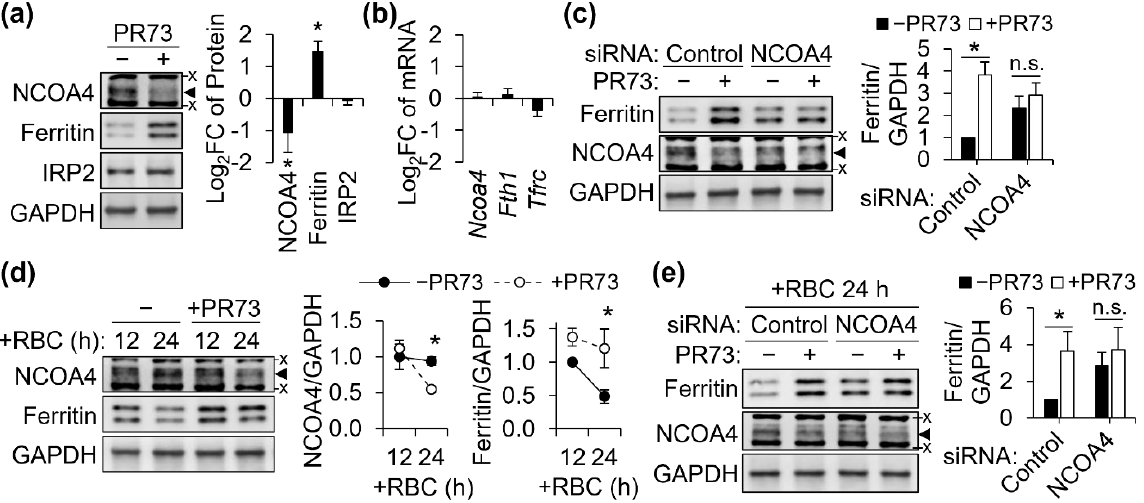
Figure 5. Hepcidin activity post-transcriptionally represses NCOA4 in J774 macrophages. J774 cells were treated with PR73, a minihepcidin analog, to mimic the biological effects of hepcidin in vitro. In experiments involving erythrophagocytosis, J774 cells were treated with opsonized red cells 4 h before PR73 treatment. For RNAi, cells were treated with NCOA4 siRNA 24 h prior to the red blood cell treatment. ( a ) Responses of NCOA4, ferritin, and IRP2 to PR73 (1 µ M) in erythrocyte-free macrophages. Relative protein abundance was normalized to GAPDH ( n = 3 independent experiments). ( b ) Lack of changes in Ncoa4 , Fth1 , and Tfrc mRNA abundance by PR73, normalized to Tbp ( n = 3 independent experiments). ( c ) NCOA4 RNAi negates the increase in ferritin by hepcidin activity (1 µ M). Ferritin quantification was normalized to GAPDH ( n = 3 independent experiments). ( d ) PR73 (4 µ M) repressed NCOA4 and prevented the facilitated turnover of ferritin between 12 and 24 h of erythrophagocytosis ( n = 3 independent experiments). ( e ) Deficiency of NCOA4 represses the magnitude of change in ferritin by hepcidin activity on erythrocyte-ingested macrophages ( n = 3 independent experiments). All data presented as mean ± SD. *, p < 0.05. n.s., not significant. x, non-specific band. (cid:74) , NCOA4